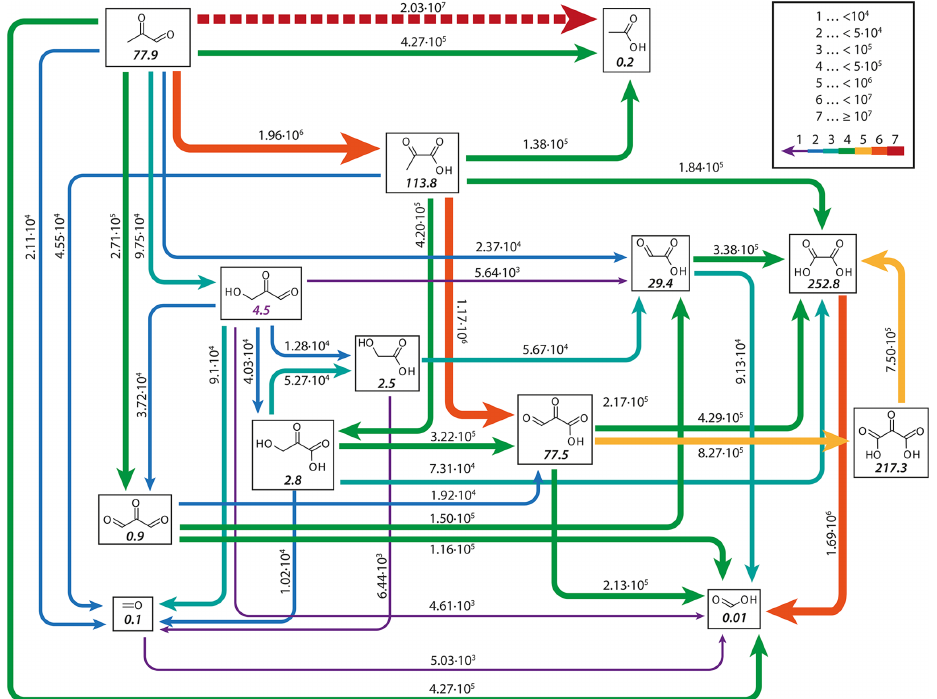
Figure 21. Chemical fluxes in the TMB oxidation experiments modelled in the scenario “RXN 0 ” averaged over the whole 3.5h of the experiment. Numbers above the arrows correspond to fluxes in molecules in cubic centimetres per second (cm − 3 s − 1 ), and bold numbers in the species boxes are concentrations in nanograms per cubic metre (ngm − 3 ) at the end of the